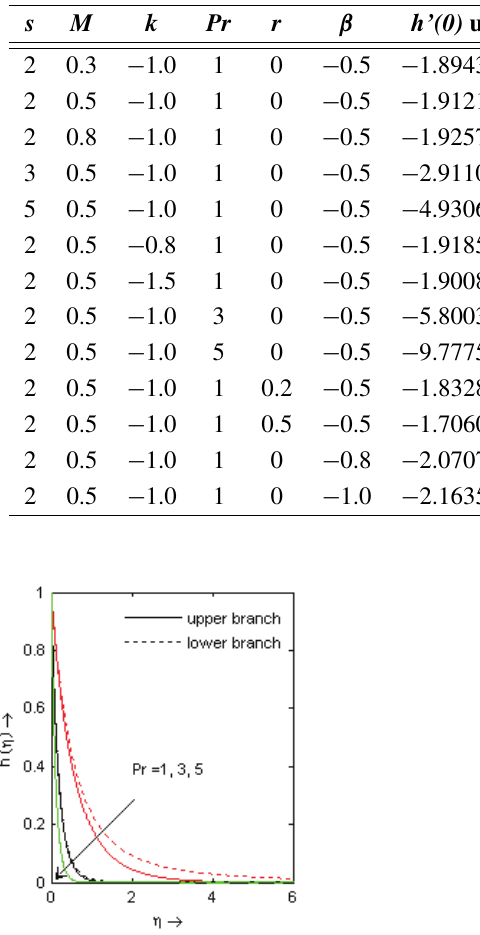
Figure 6. Dual temperature profiles h ( (cid:29)/ for various values of ˇ with s